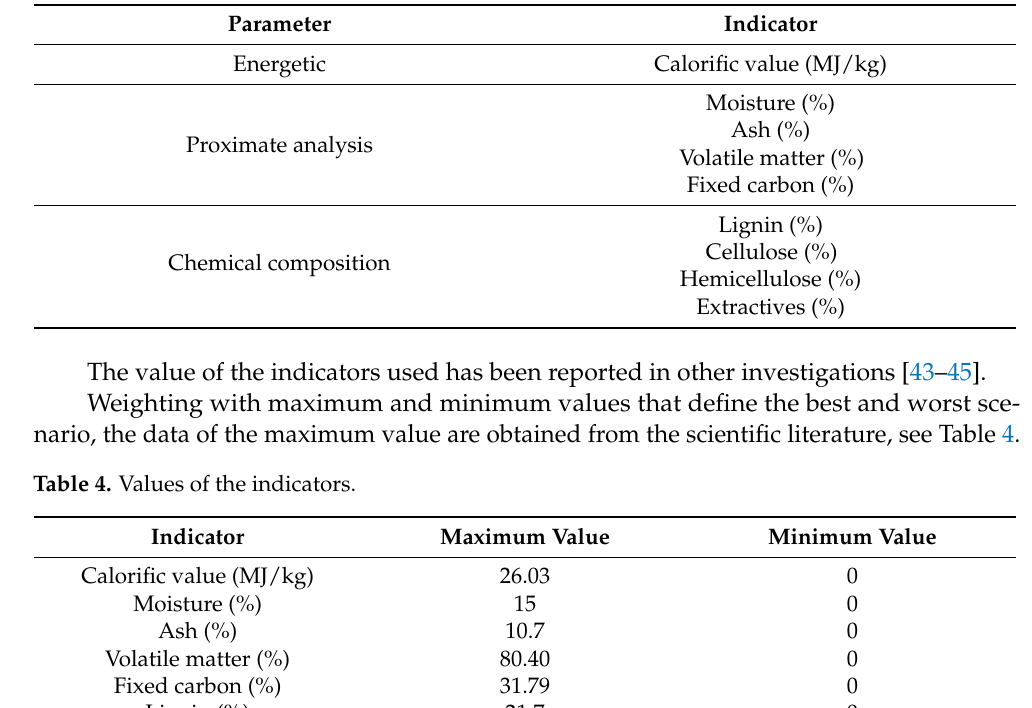
Table 3. Parameters and indicators used in the multicriteria analysis.